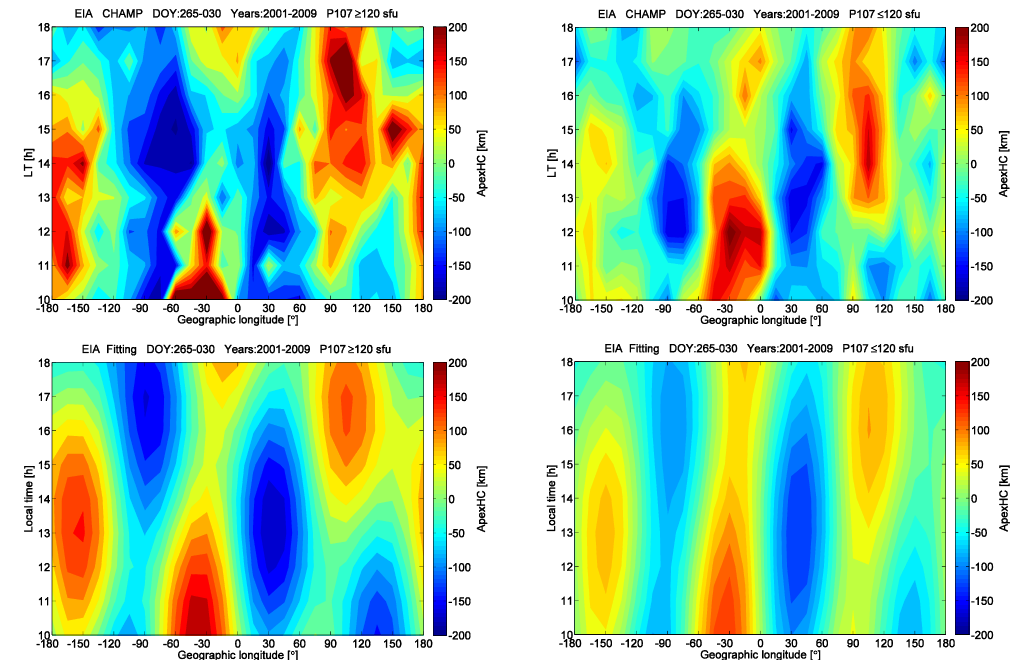
Fig. 10. The local time versus longitudinal distribution of ApexHC during months around December solstice, observations (top) and synthetic signal (bottom) during high (left) and low (right) solar flux levels.